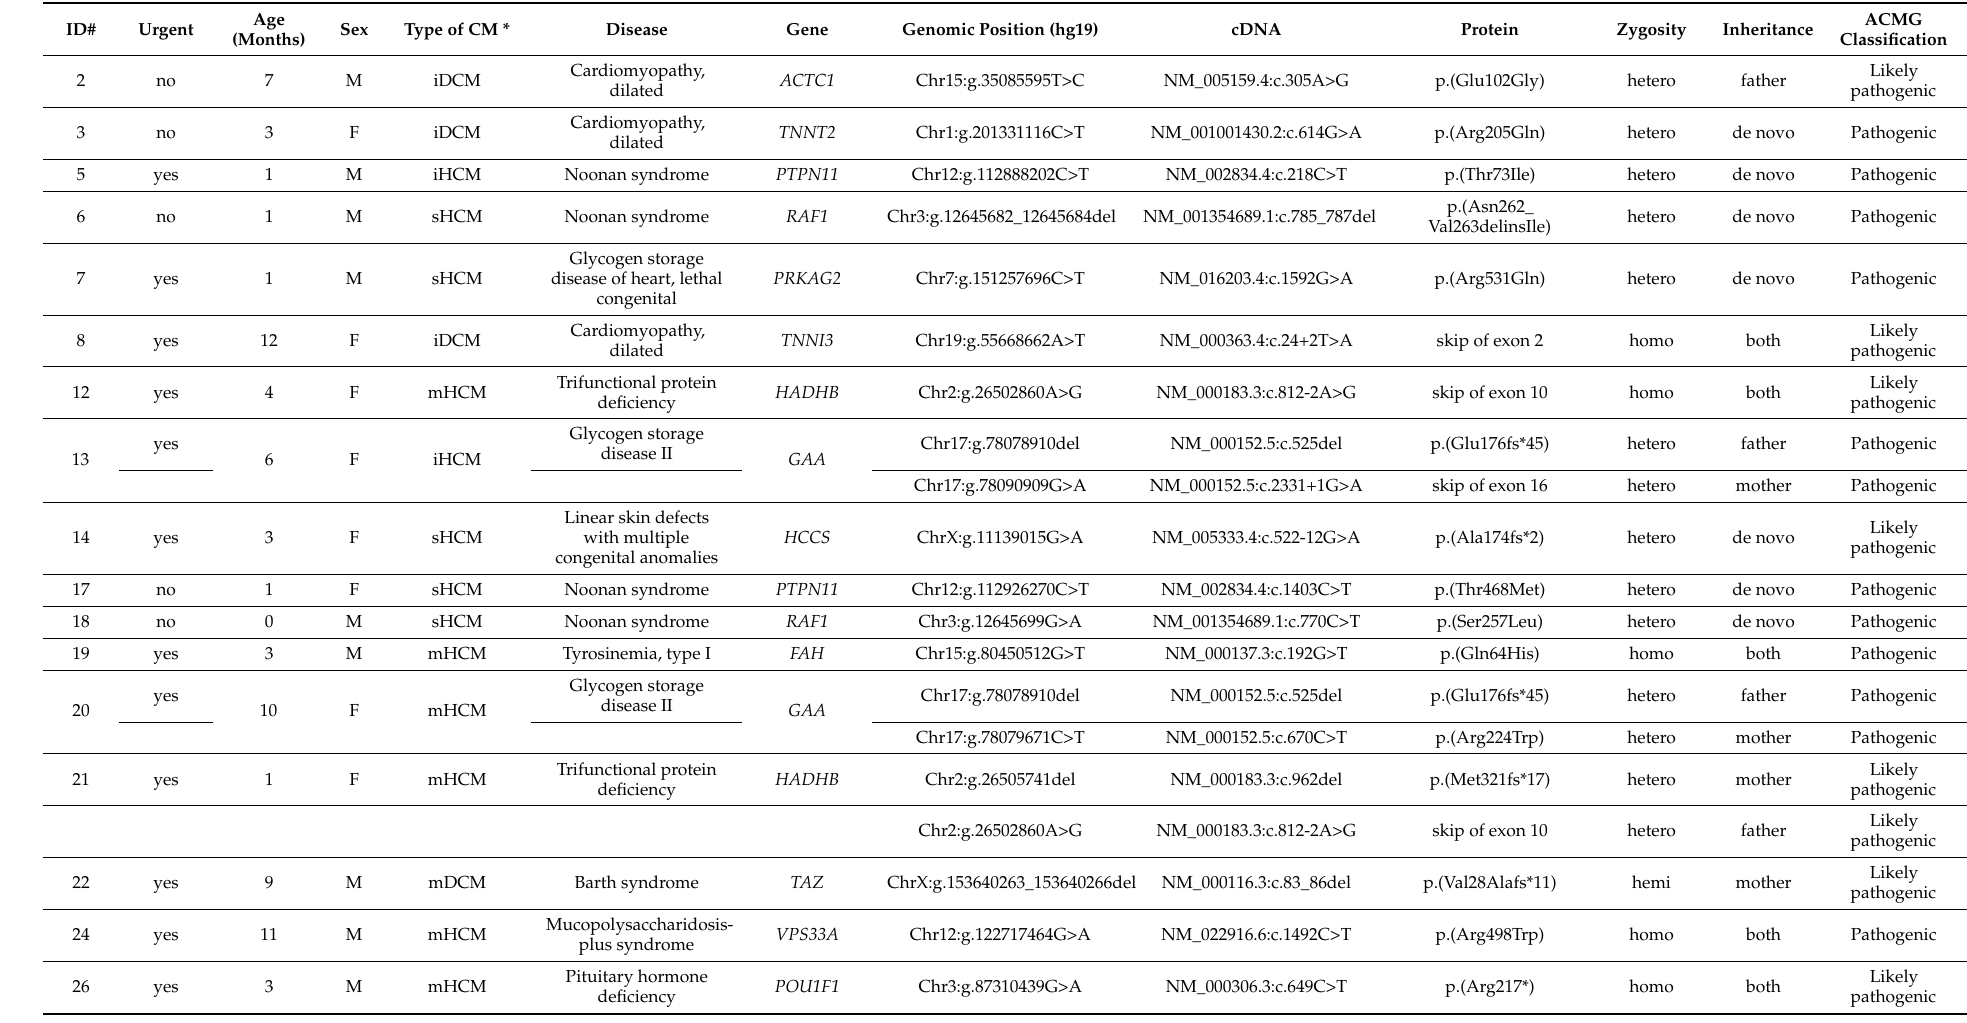
Table 2. Clinical presentation and list of identified mutations in our pediatric CM